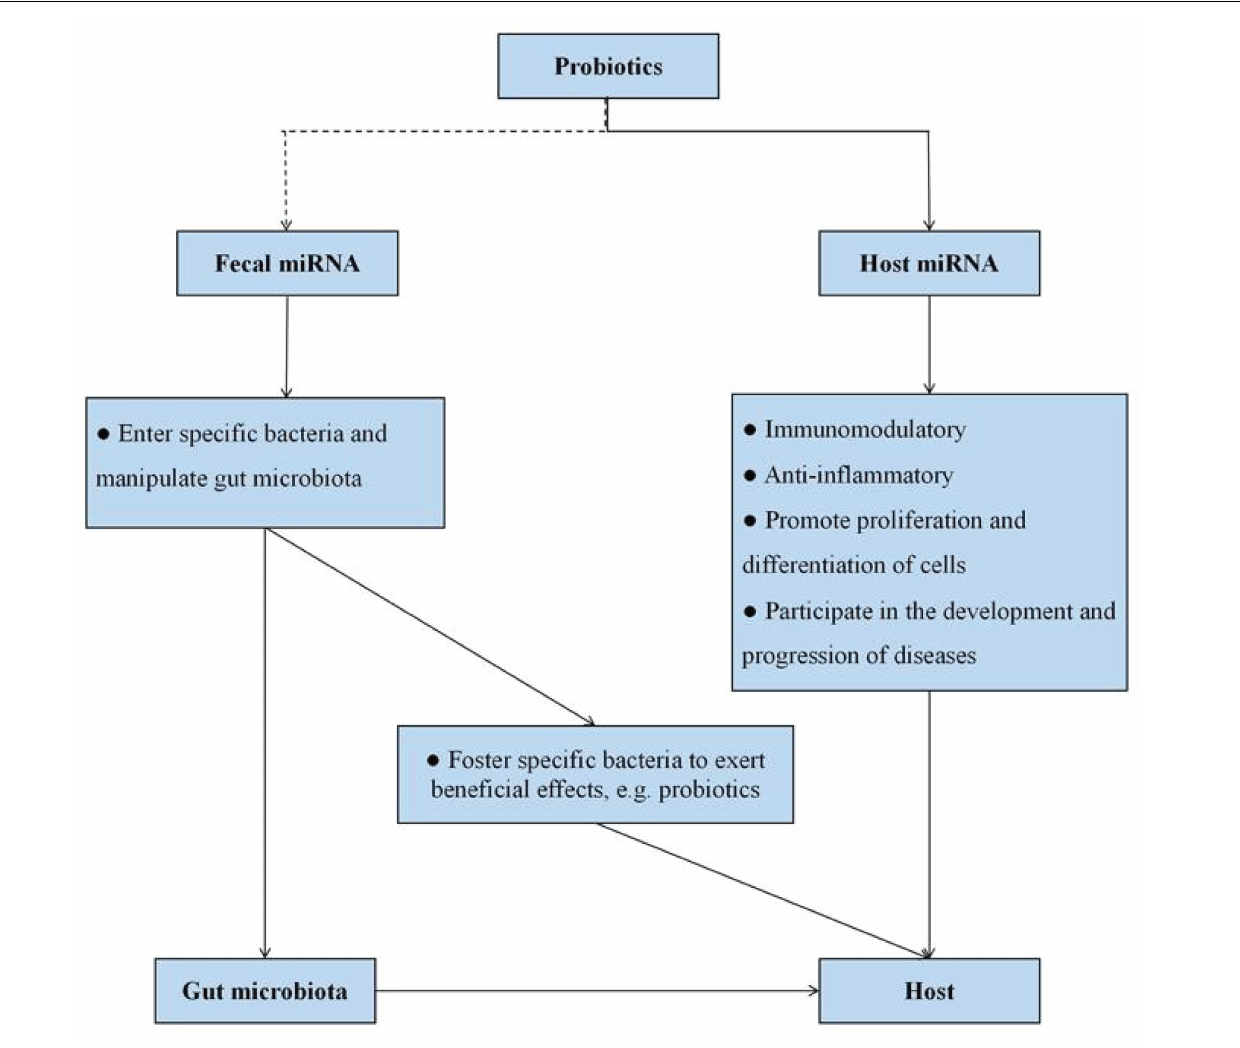
FIGURE 3 | Potential miRNA-based molecular mechanism of probiotics action. Probiotics can influence host miRNA expression, thereby favoring numerous host functions. On the other hand, host cells foster specific bacteria to control intestinal homeostasis and exert beneficial effects on the host itself via fecal miRNA and plant-derived miRNA. The dotted line represents the lack of conclusive evidence in the relationship at